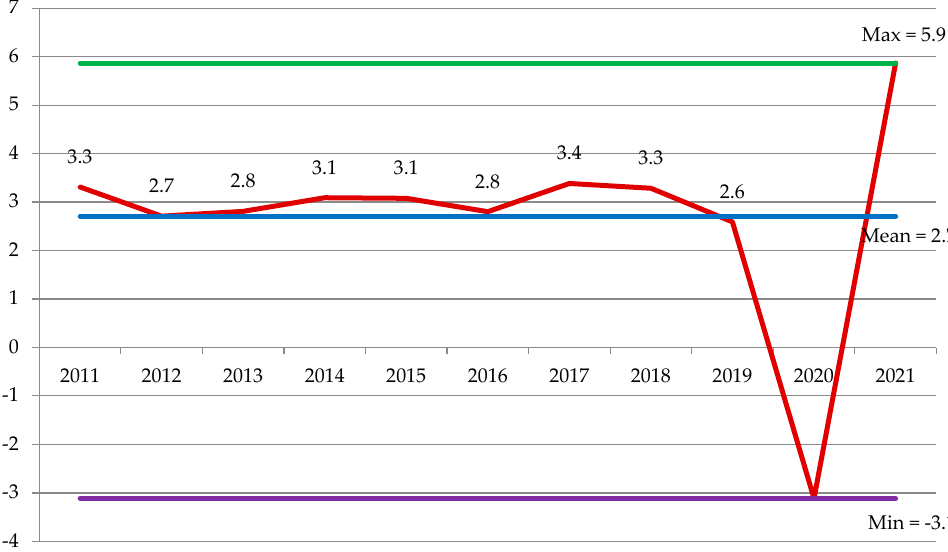
Figure 6. The world GDP growth rates (%) and their variability in 2011–2021.